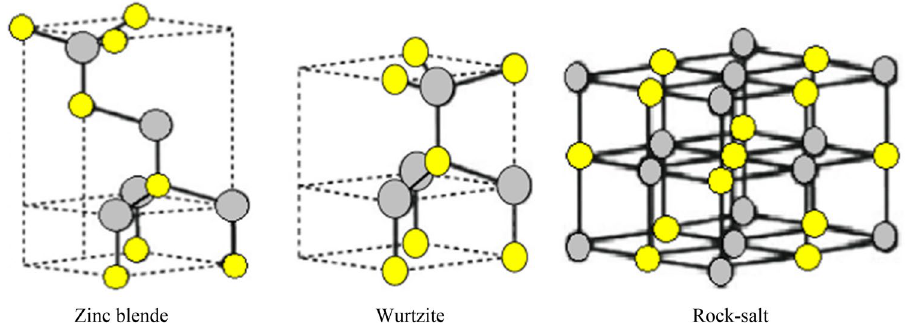
Fig. 5 Different forms of ZnO crystals